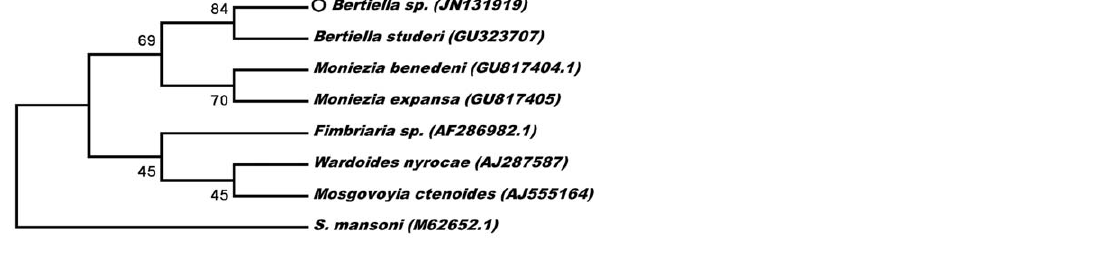
Figure 2. Phylogenetic tree between Bertiella sp. from this study (circle) and other Anoplocephalidae. Numbers in parentheses are GenBank accession numbers. Schistosoma mansoni were used as outgroup.